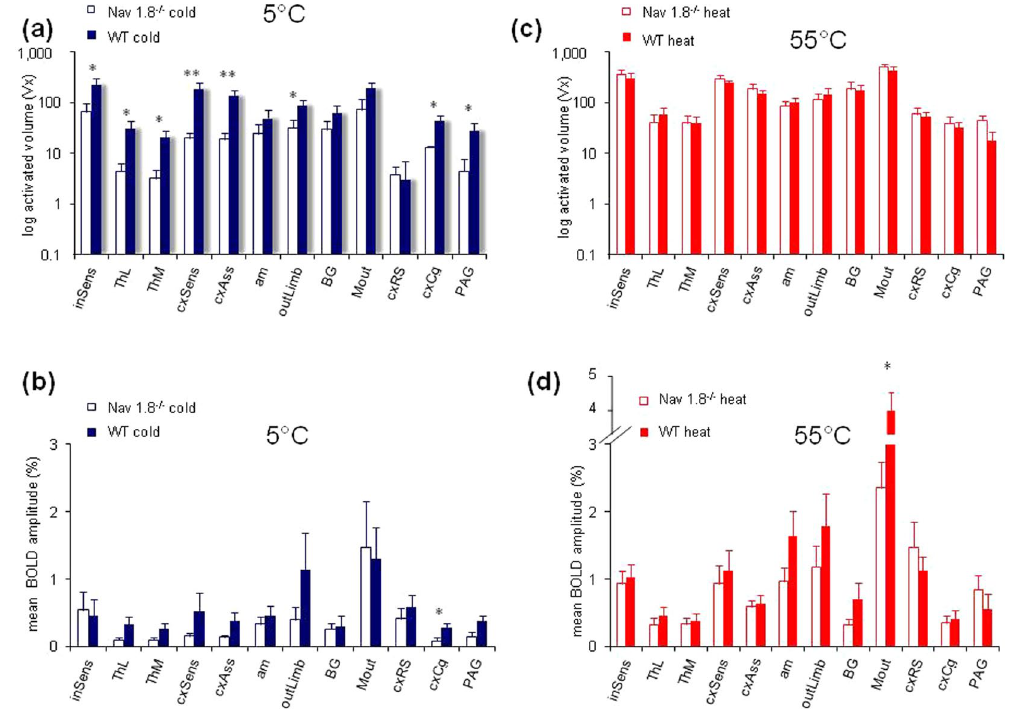
Figure 3. Comparison of activated volume and change of mean BOLD amplitude in functional groups of brain structures in Na V 1.8 − / − and WT mice following cold (5 °C) and heat (55 °C) stimulation. A functional group analysis was calculated for two BOLD parameters (activated volume expressed as number of activated voxels: insets a/c (note the logarithmic scale) and mean BOLD amplitude: insets b/d ) for cold stimulation (5 °C: blue) and heat stimulation (55 °C: red) separate for the two genotypes (Na V 1.8 − / − : open bars, WT: closed bars). Functional groups comprise brain structures with comparable functional/anatomical aspects. The functional group analysis provides a deeper insight, which functional systems show significant differences between Na V 1.8 − / − and WT mice. The data are presented as mean values ± SEM, n = 10 for WT and Na V 1.8 − / − , respectively. Percentage declaration is referred to 100% of total mean BOLD amplitude. Significant differences between Na V 1.8 − / − and WT mice for each stimulation condition are marked with asterisks: ** p ≤ 0.01; * p ≤ 0.05; Student’s t-test, two-sample;